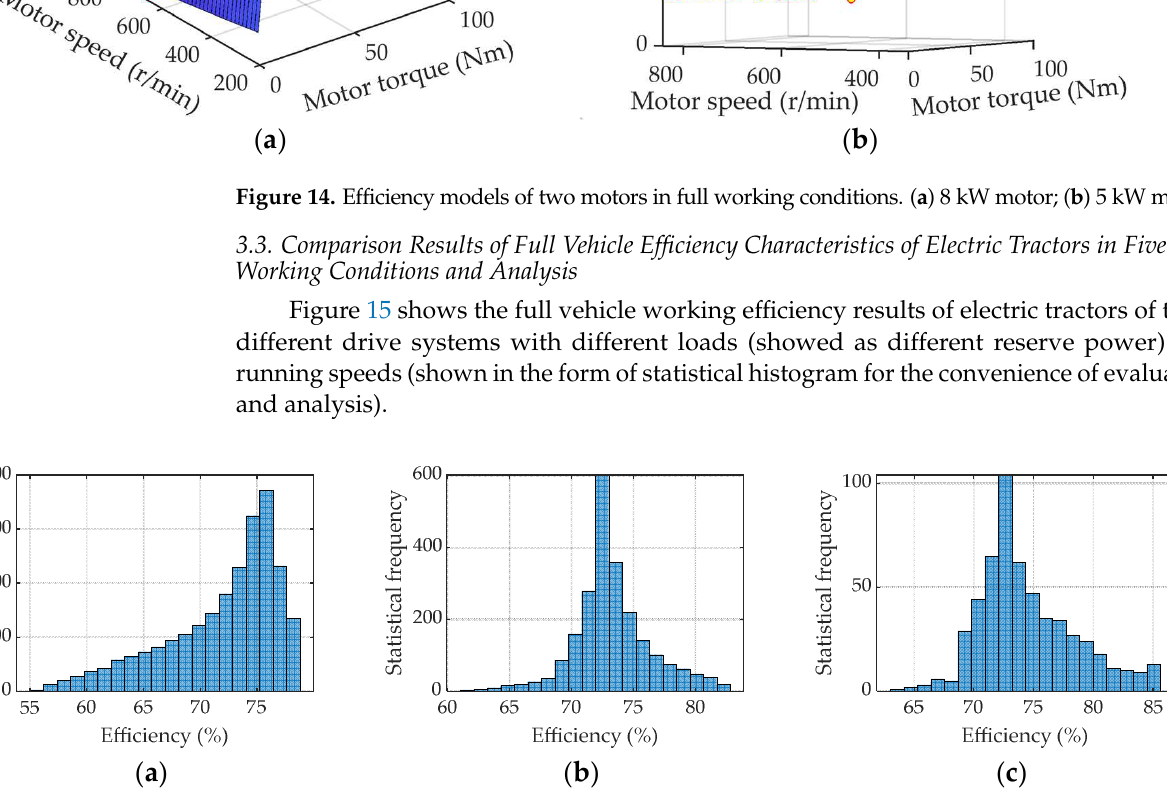
Figure 15. Estimation results of the full vehicle working efficiency of electric tractors with different drive systems. ( a ) 4 wheel independent drive system; ( b ) Rear wheel independent drive system; ( c ) Dual motor coupling drive system.